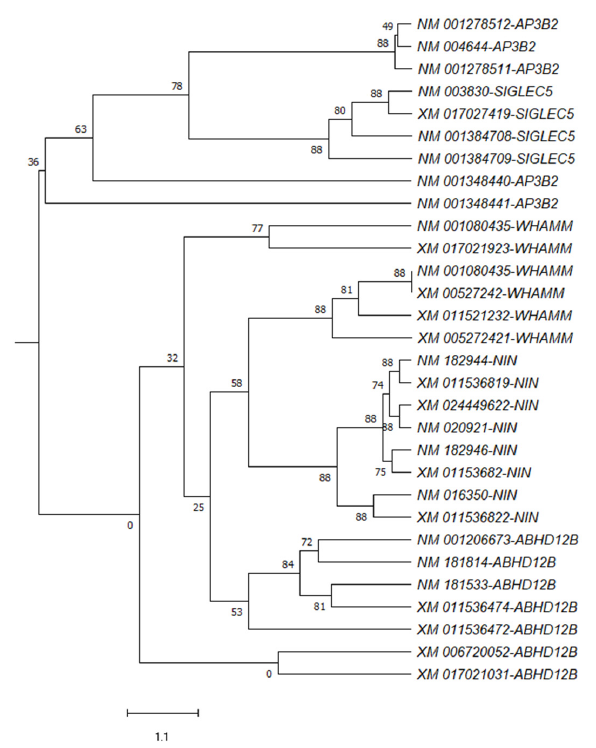
Figure 3. Classical clustering showed the transcripts might be grouped into two clusters. AP3B2 and SIGLEC5 transcripts clustered together, while the rest of the transcripts clustered separately.